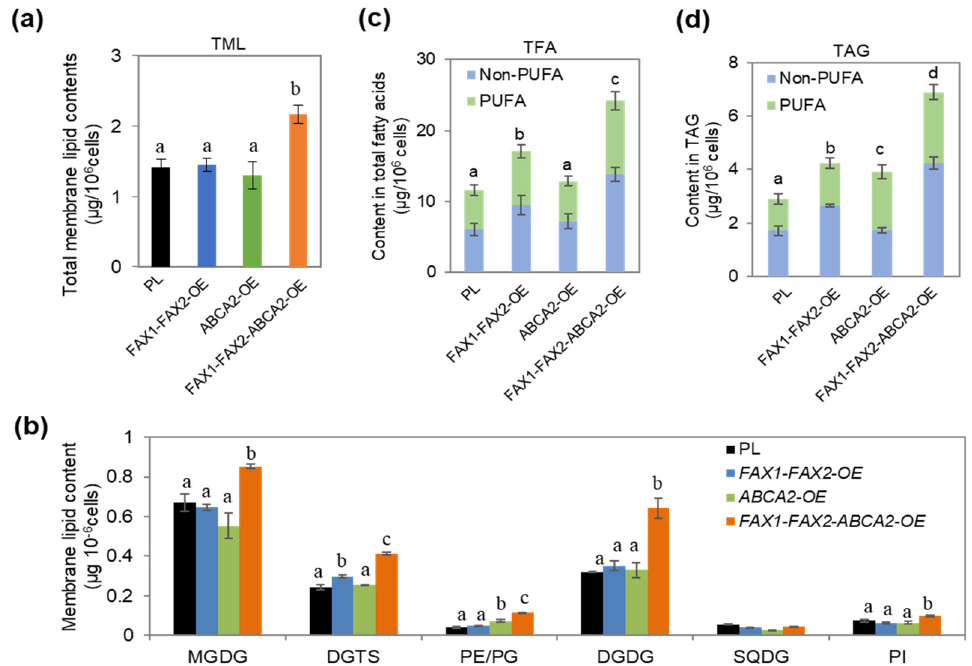
Figure 2. Alterations of the membrane glycerolipid levels and fatty acid compositions under TAP − N for 48 h. ( a ) Total membrane lipid contents. ( b ) Profile of individual membrane component content. ( c , d ) PUFA and non − PUFA content in TFA and TAG, respectively. PUFA, polyunsaturated fatty acids; non − PUFA, monounsaturated and saturated fatty acids; TFA, total fatty acids; TAG, triacylglycerols; PI, phosphatidylinositol; DGDG, digalactosyldiacylglycerol; DGTS, diacylglycerol- N,N,N-trimethylhomoserine; SQDG, sulfoquinovosyldiacylglycerol; PE, phosphatidylethanolamine; MGDG, monogalactosyldiacylglycerol; PG, phosphatidylglycerol. Error bars represent standard errors calculated from four biological replicates. Statistically significant difference by Tukey’s